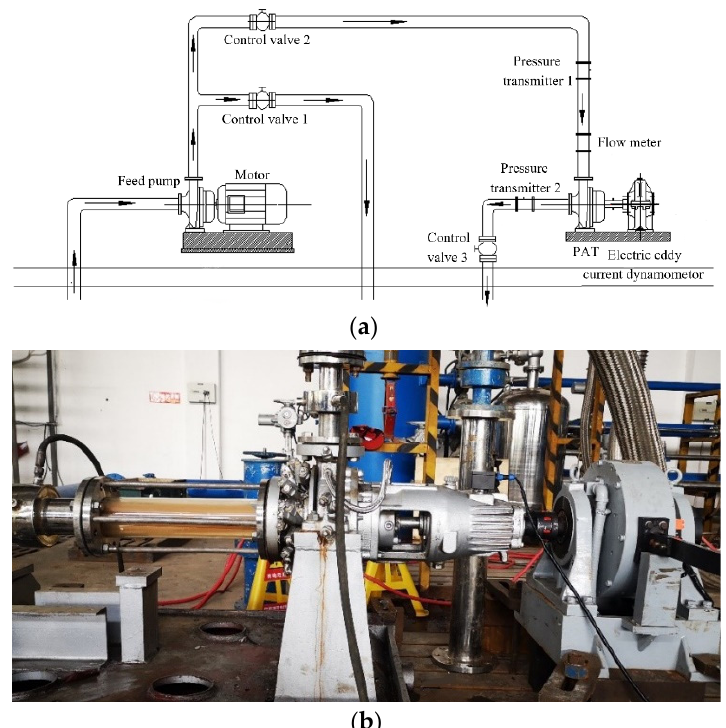
Figure 5. Schematic of the current experimental system ( a ), and a picture of this system in the lab ( b ).